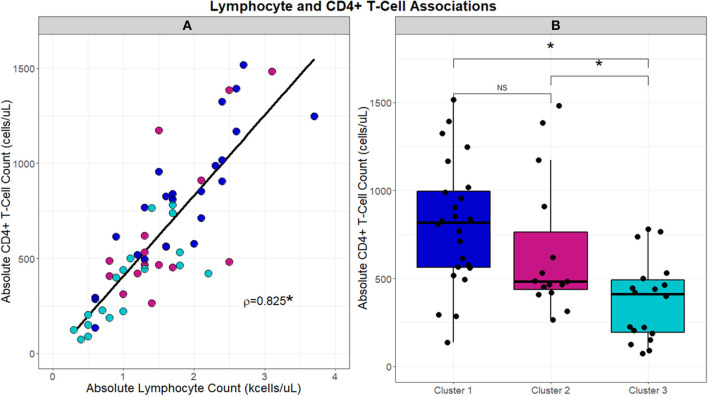
Scatterplot in (A) demonstrates the strong direct relationship (Spearman's correlation coefficient; rho = 0.8329, p < 0.001) that is observed between absolute lymphocyte counts (kcells/μL) and absolute CD4+ T-cells (cells/μL). Box and whisker plots in (B) highlight the differences in absolute CD4+ T-cells (cells/μL) that are observed between clusters. A significant association was identified by Kruskal-Wallis test between clusters and absolute CD4+ T-cells (p = 0.0008). Post-hoc analysis with Dunn's test demonstrated significantly reduced absolute CD4+ T-cell counts, denoted with an asterisk (*), in Cluster 3 compared to Clusters 1 and 2 (BH-adjusted p = 0.0005 and 0.0929, respectively). No difference (NS) in absolute CD4+ T-cell counts was observed between Clusters 1 and 2.